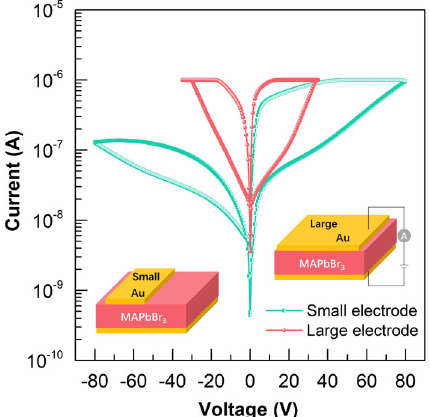
Fig. 4 I – V curves of an Au/MAPbBr 3 /Au device in the dark with different top-electrode areas.